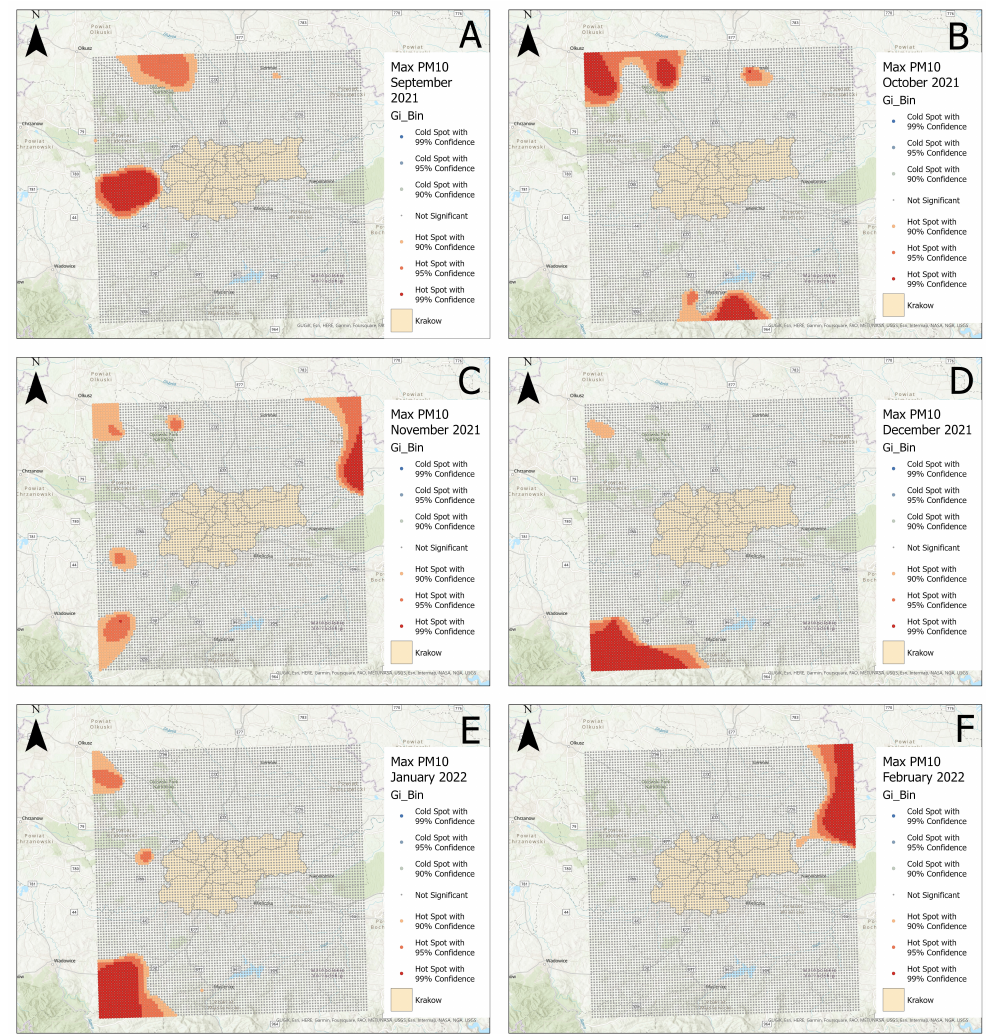
Figure 16. Hot-spots and cold-spots maps for monthly maximum PM10 concentration using Getis-Ord G ∗ . The maps illustrate clustering in September ( A ), October ( B ), November ( C ), December 2021 ( D ), i January ( E ), and February 2022 ( F